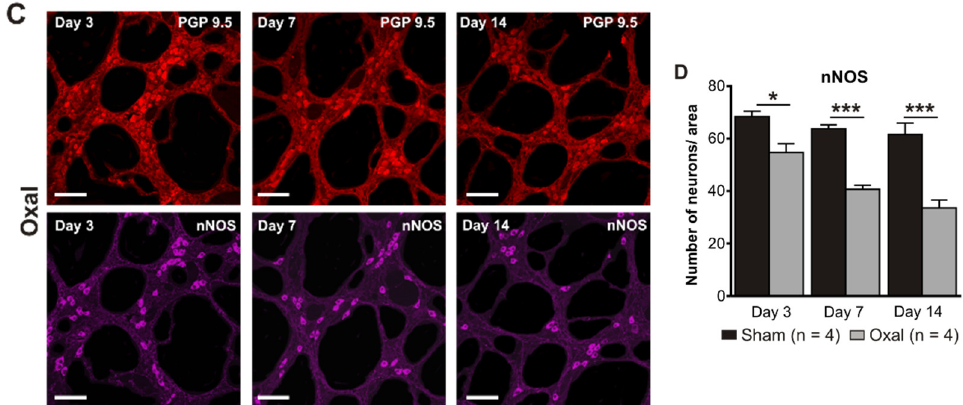
Figure 3. Effects of repeated oxaliplatin administration on the myenteric neurons and inhibitory motor neurons in whole mount preparations of the stomach. ( A ) Myenteric neurons labelled with the pan-neuronal marker PGP9.5 (red) and ( C ) inhibitory motor neurons labelled with the antibody for neuronal nitric oxide synthase (nNOS) (purple) in the gastric corpus at days 3, 7, and 14 following the injection of sterile water (sham) and oxaliplatin (oxal). Scale bar: 100 µm. ( B , D ) Group data showing the average number of PGP9.5-IR neurons and nNOS-IR neurons counted per a 0.25 mm 2 area in wholemount preparations of the gastric corpus of sham and oxal-treated mice. Data are presented as the mean ± SEM. The number of animals is shown in parentheses. *** p < 0.001; * p < 0.05.